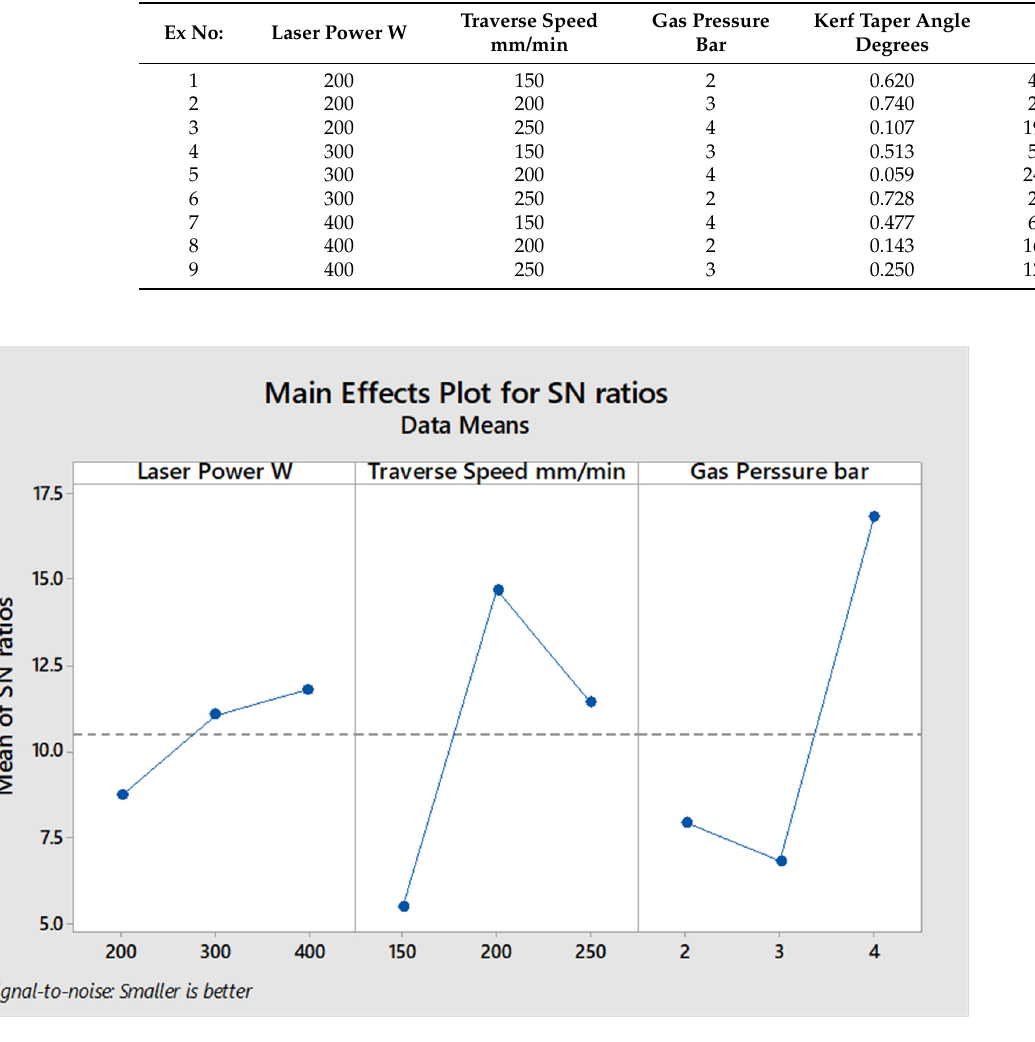
Figure 3. S/N ratio average value of input cutting parameters of the 2 mm thickness of sugar palm fiber reinforced unsaturated polyester (SPF-UPE) composite cut by laser beam cutting process. Table 8. S/N ratio response table of input cutting parameters of the 2 mm thickness off SPF-UPE composite cut by laser beam cutting process.